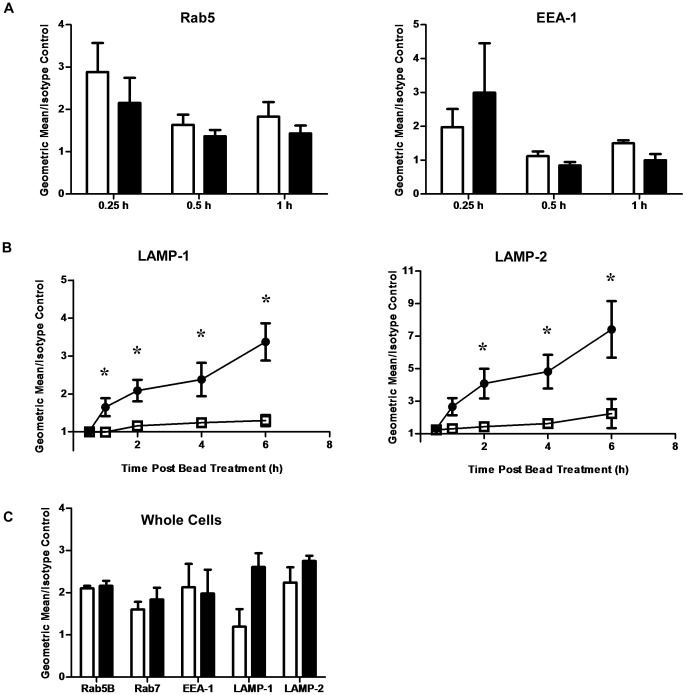
Magnetic bead phagosomes from p110α knockdown cells show defective acquisition of the lysosomal proteins LAMP-1 and LAMP-2.Kinetic analysis of phagosome maturation by flow organellometry shows A) normal acquisition of the early endosomal marker Rab5 and EEA-1, and B) marked defects in the acquisition of the lysosomal membrane proteins LAMP-1 and LAMP-2 by p110α knockdown cells. Solid circles  =  control cells, empty squares  =  p110α knockdown cells. Timepoints were taken at 30 minutes, 1 hour, 2 hours, 4 hours, and 6 hours post bead treatment. Data are means +/− s.e.m., from five independent experiments. Ratios of geometric mean over isotype control of 1 or less are interpreted as negligible signal. *p<0.05. C) Whole cell expression of phagosome markers are at similar levels in control and p110α knockdown cells. Staining of permeabilized cells and flow cytometric analysis of various phagosome markers in control and p110α knockdown cells showed no significant differences in cellular levels. Empty bars  =  control cells, solid bars  =  p110α knockdown cells. Data are means +/− s.e.m., from three independent experiments.